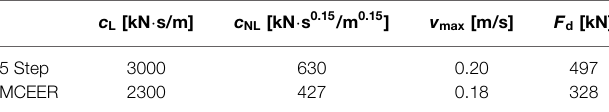
TABLE 2 | Non-linear dampers characteristics along the Y direction